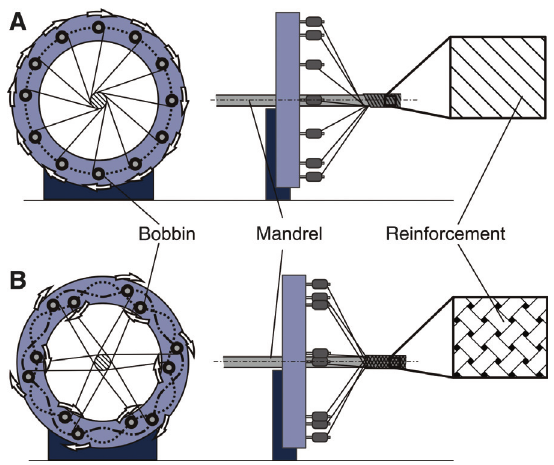
Figure 6 Process principle with resulting reinforcement types: (A) continuous winding and (B)